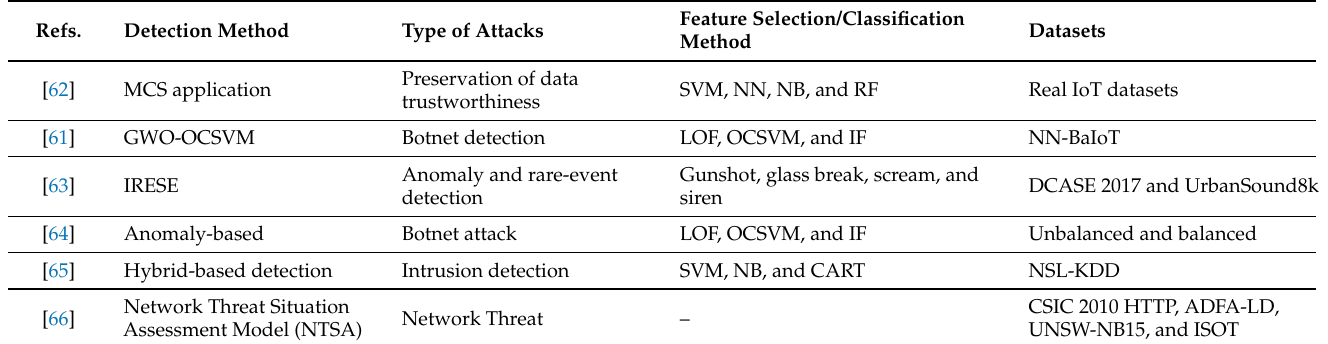
Table 5. Unsupervised machine learning methods for cyber attack detection in IoT.